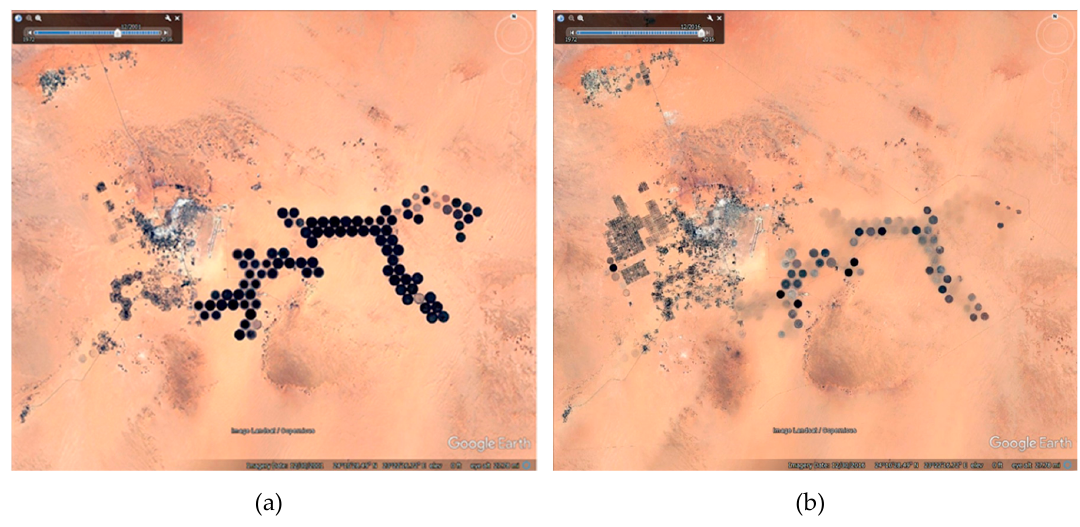
Figure 11. Irrigated agricultural fields in the Al-kufrah Oasis group: ( a ) before December 2012, ( b ) after December 2016 [55].